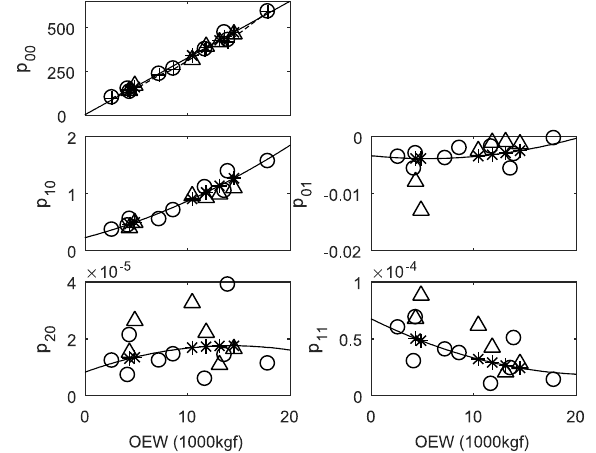
Figure 4. p-Coefficients of the fuel consumption surface (WFB) fit for the maximum constant altitude case. 'o' training samples, ' Δ ' validation samples, '*' predicted value on the validation samples, on p 00 '- - + - -' Weight of Fuel Burned at Start WFBS = 2% of MTOW (Maximum Take-Off Weight).